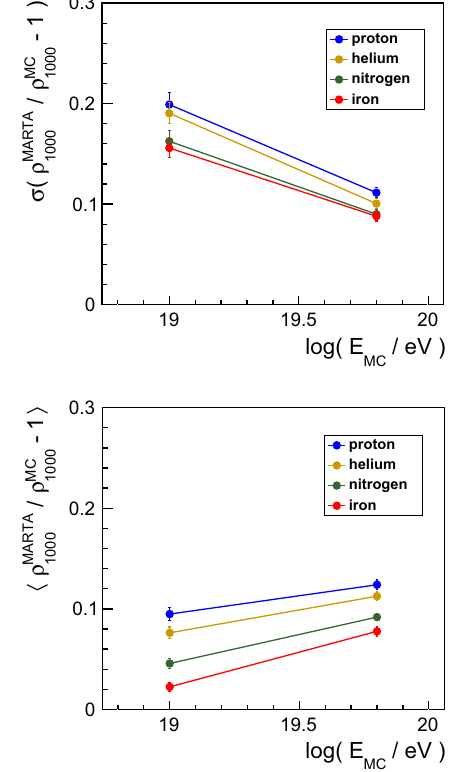
Fig. 9 ρ MARTA resolution (top) and bias (bottom) for different pri- 1000 maries at θ = 38 ◦ , for E = 10 19 eV and E = 10 19 . 8 eV obtained with QGSJET-II.04. Similar results were obtained with the EPOS-LHC interaction